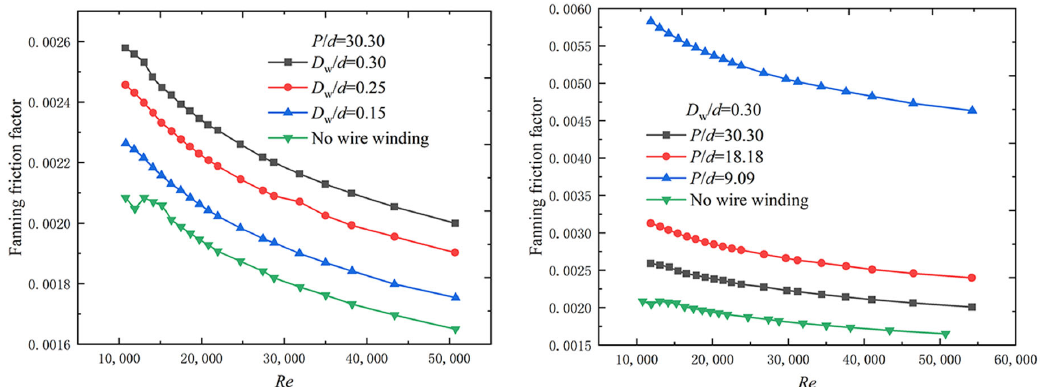
Figure 20. Variation of Fanning friction factor with filament winding parameters [19].